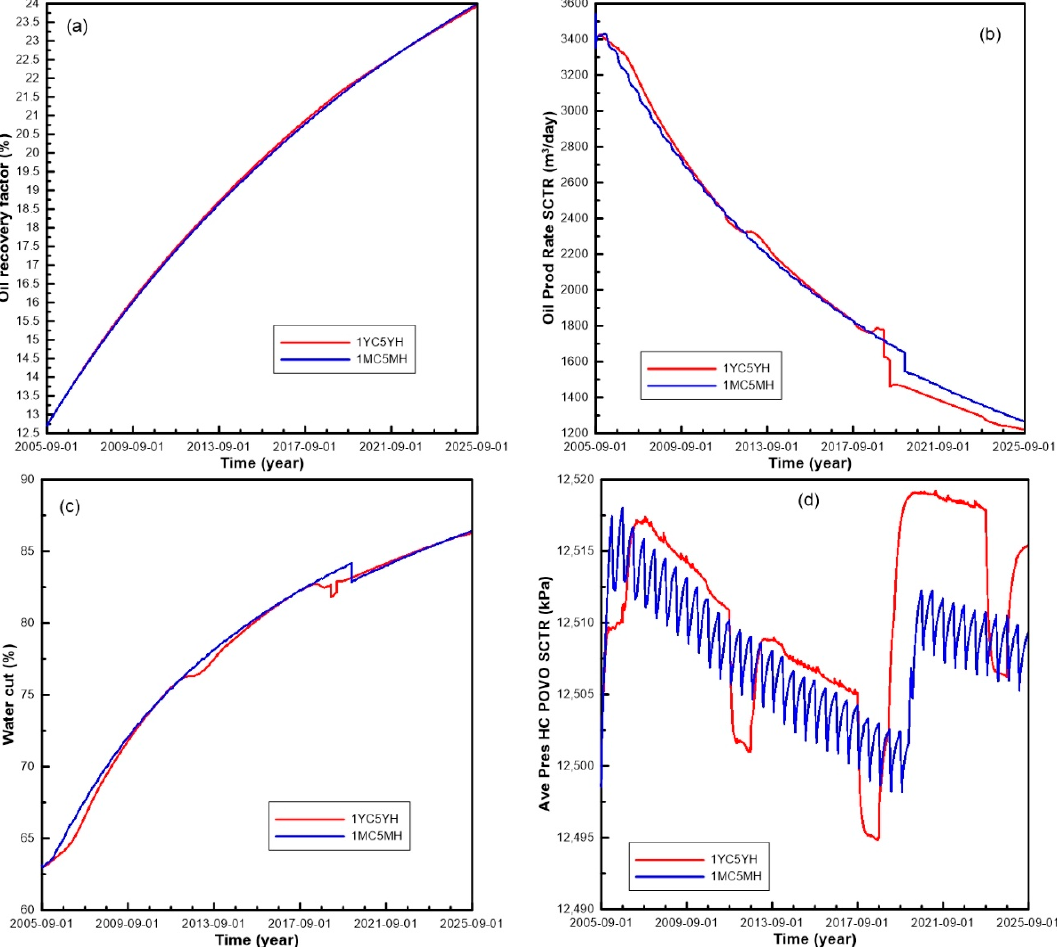
Figure 12. Simulated result curves of oil recovery factor ( a ), oil production rate ( b ), water cut ( c ) and average reservoir pressure ( d ) of during the CO 2 flooding with a WAG ratio of 1:5.